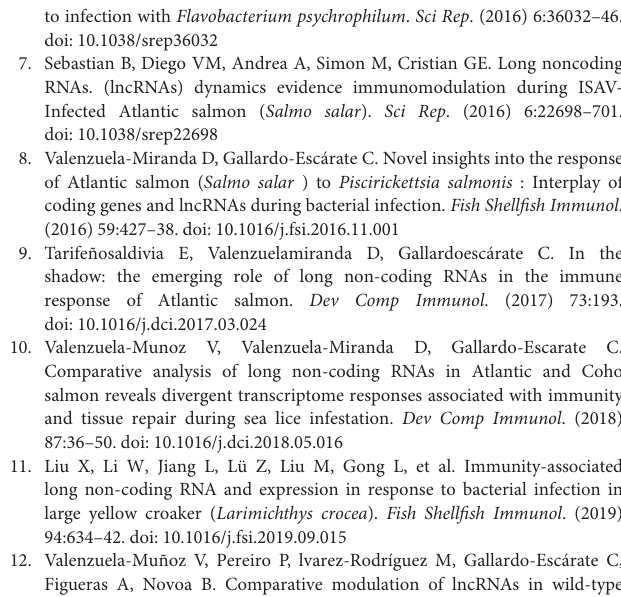
Figueras A, Novoa B. Comparative modulation of lncRNAs in